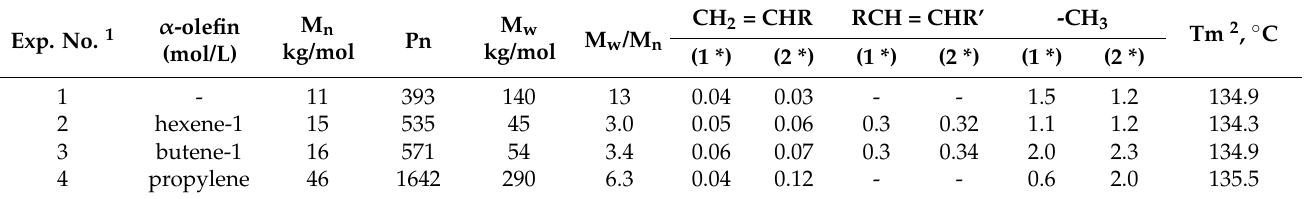
Table 3. Data on the effect of α -olefins on the molecular structure of polymers obtained from ethylene polymerization in the presence of α -olefins.